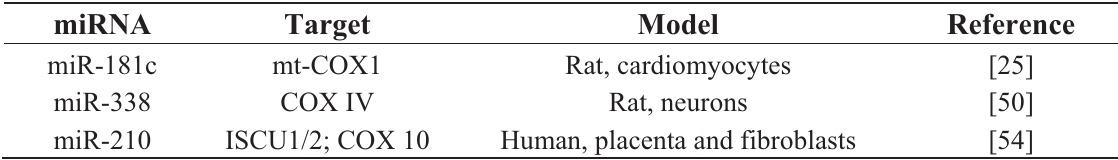
Table 1. MicroRNAs (MiRNAs) with reported action directly on mitochondrial electron transport chain (ETC)